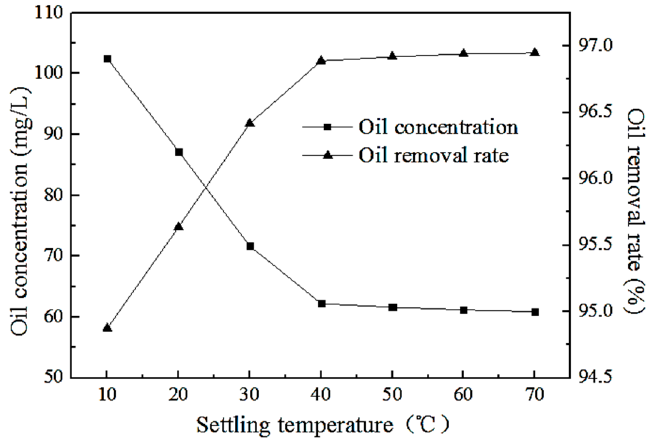
Figure 4. Influence of settling temperature on oil concentration and oil removal rate.